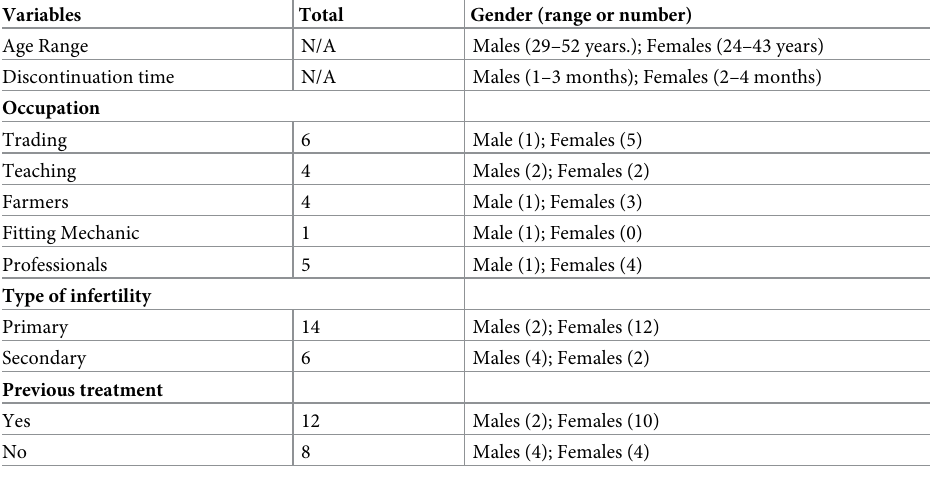
Table 1. Socio-demographic data of infertile